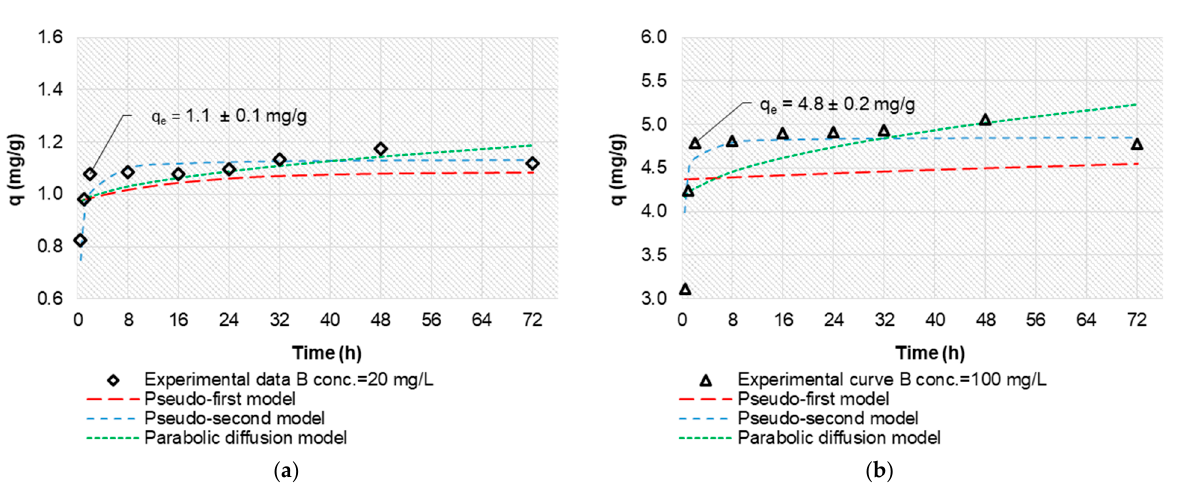
Figure 7. Effect of contact time on boron sorption efficiency using Mn-biosorbent hydrogel beads and boron sorption fit with kinetic and diffusion model; initial boron concentration: 20 mg/L ( a ) and 100 mg/L ( b ). Table 2. Kinetic parameters for boron sorption on the Mn-biosorbent hydrogel beads at 20 ± 1 °C. Initial Boron